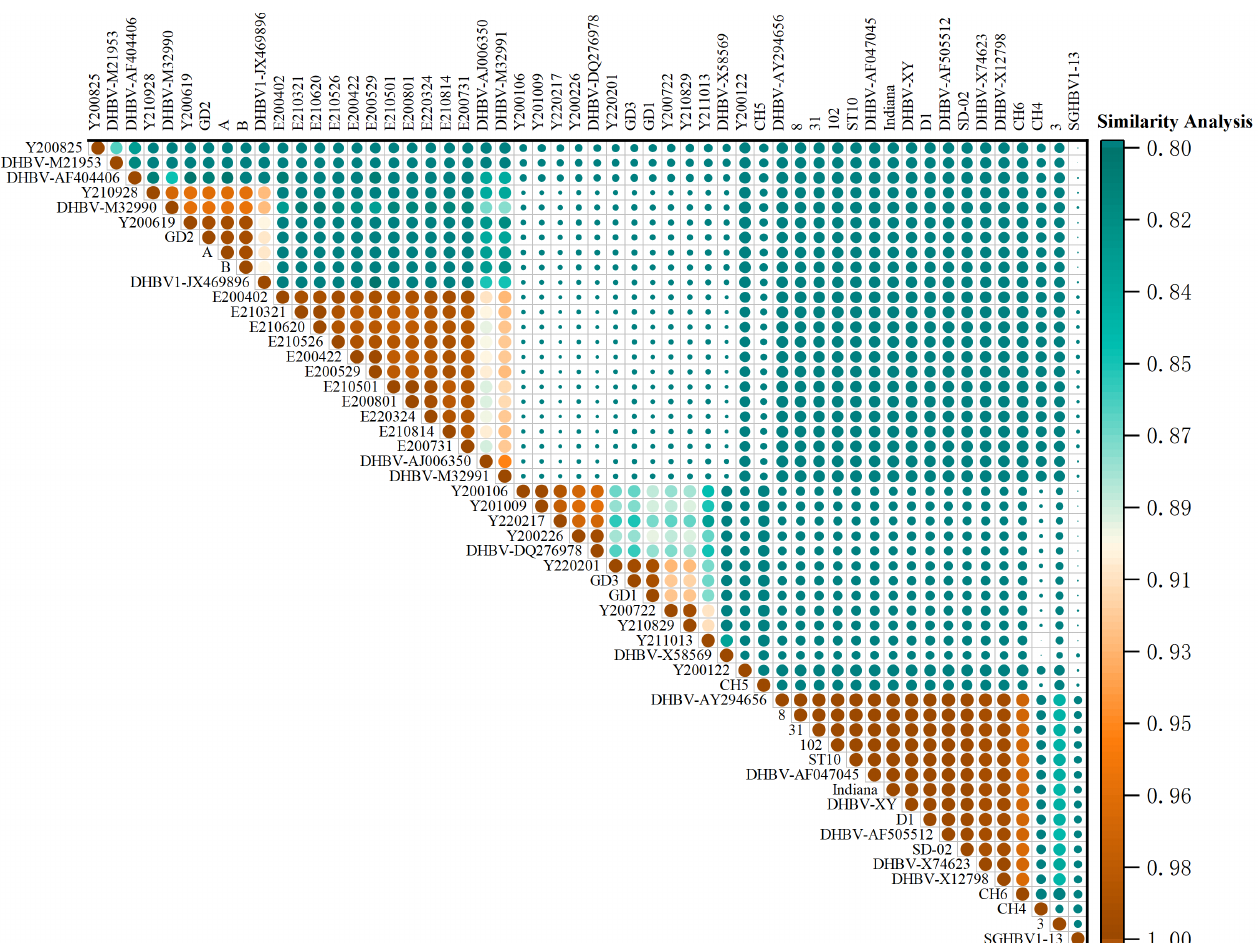
Figure 1. Heatmap of the similarity analysis of the entire genome of the DHBV strains and reference strains obtained in this study (upper right: different identity values are expressed in gradient colors ranging from 80% to 100%).